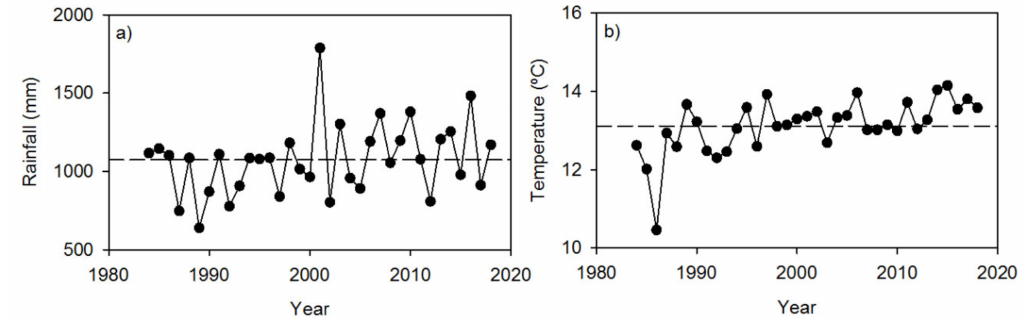
Figure 2. Annual series for ( a ) rainfall and ( b ) temperature. Horizontal dotted line indicates the long-term mean for each variable.